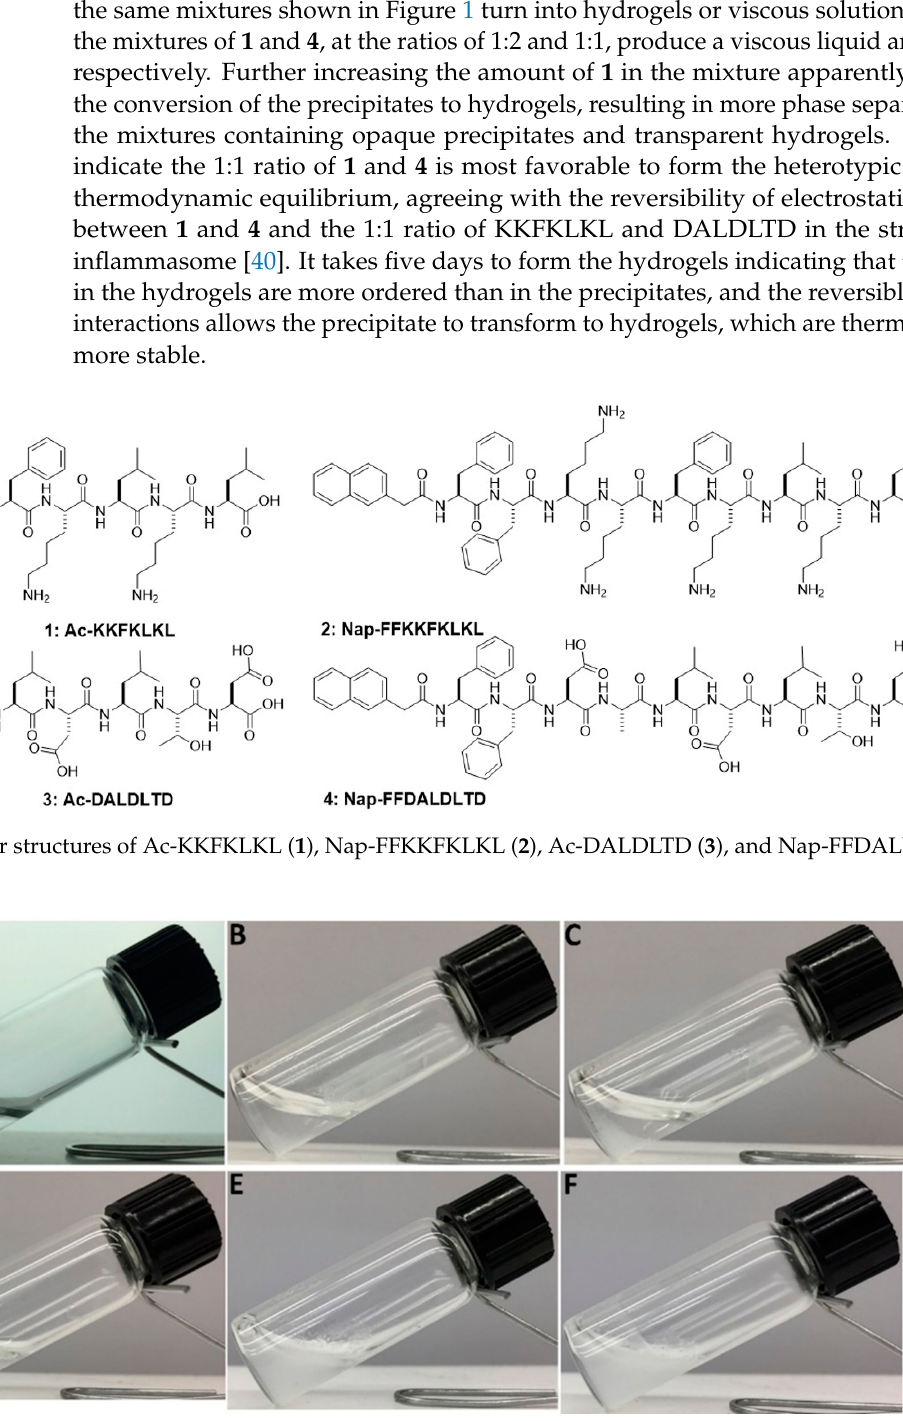
Figure 1. Optical images of 0.4 wt% NapFFDALDLTD ( 4 ) in water ( A ) without or with the addition of ( B ) 0.5, ( C ) 1, ( D )